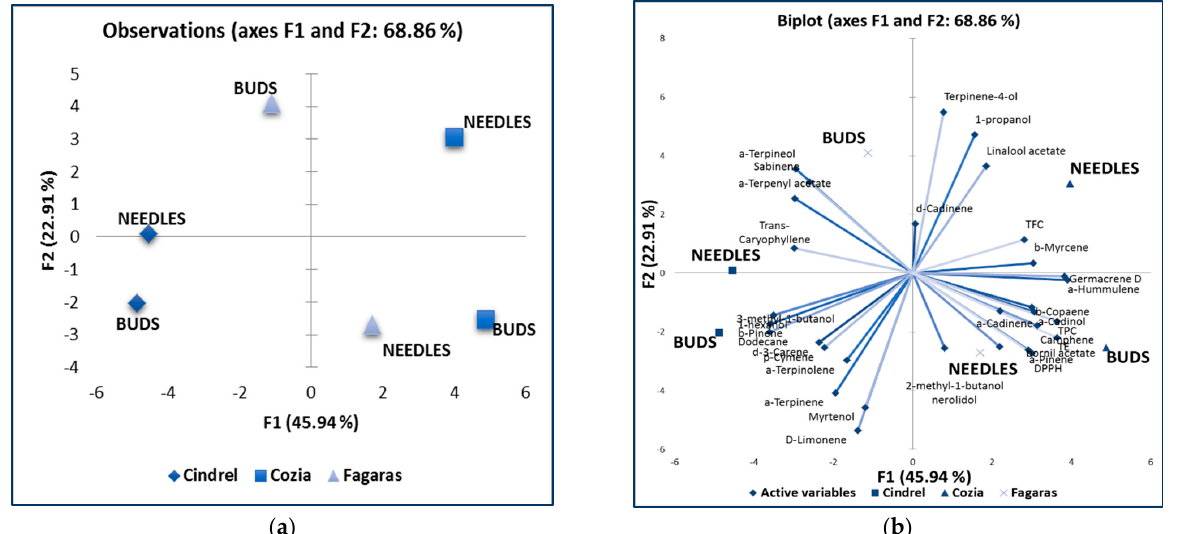
Figure 1. Differentiation of bud and needle sources based on the compositional profile; ( a ) PCA plot illustrating differentiation of bud and needle sources based on the compositional profile. Colored symbols correspond to the 3 regions defined in this study. The first two principal axes explained approximately 69 % of the variance; ( b ) PCA plot showing the multivariate variation among the 3 different regions in terms of chemical compositional variables. Vectors show the contribution of each compositional variable to the overall distribution as well as their strength.